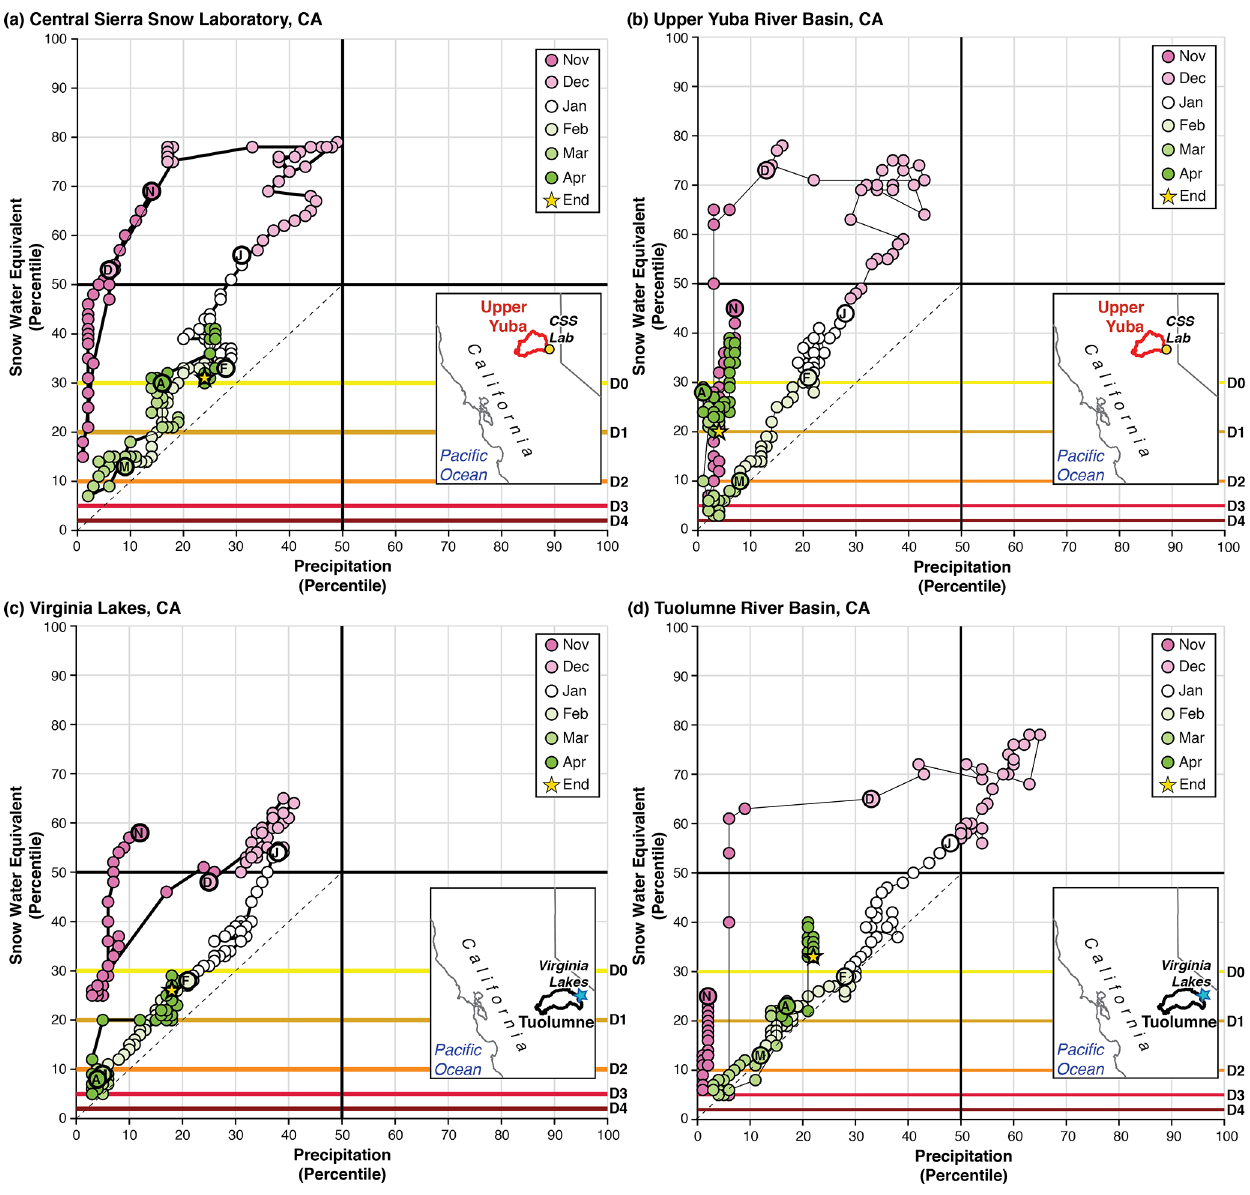
Figure 6. Phase diagrams for water year 2020: (a) CSS Lab SNOTEL, (b) upper Yuba River basin HUC-8, (c) Virginia Lakes SNOTEL, and (d) Tuolumne River basin HUC-8. Locations of watersheds and SNOTEL stations are noted on inset